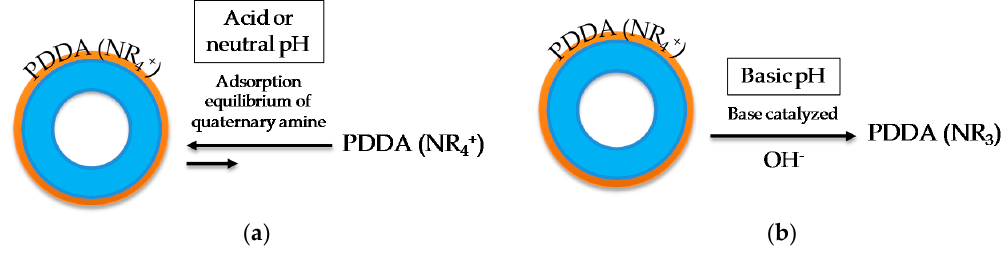
Figure 7. Behaviour of deposited PDDA layers as a function of pH: ( a ) Acid or neutral pH and ( b ) basic pH.